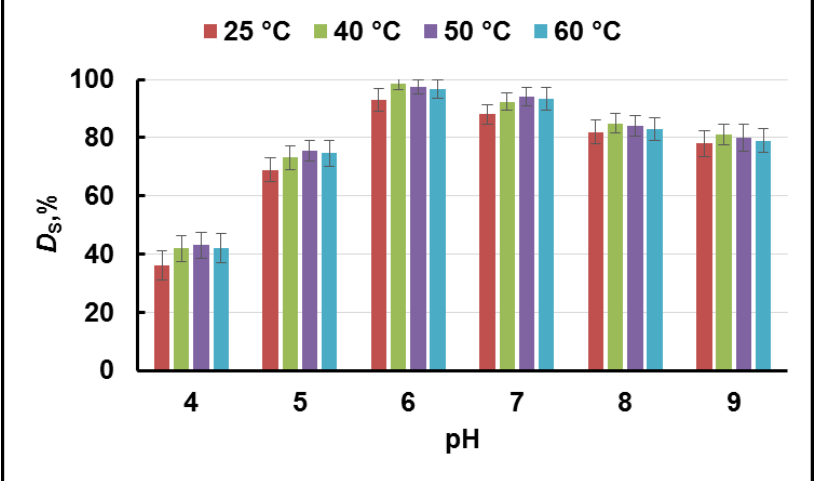
Figure 7. Dependence of the degree of sorption ( D S , %) of Cr(III) ions onto Cr(III)-IIM on pH and temperature.